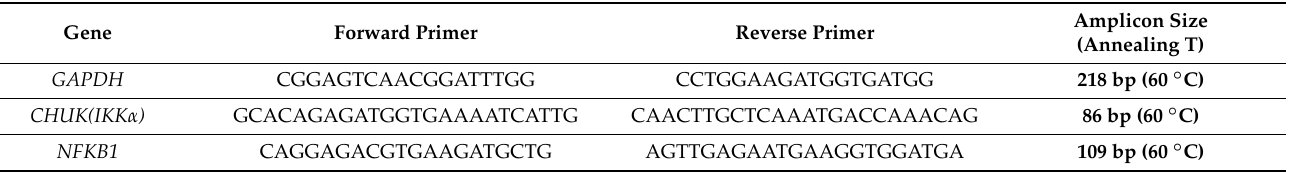
Table 1. List of primers used for Real time